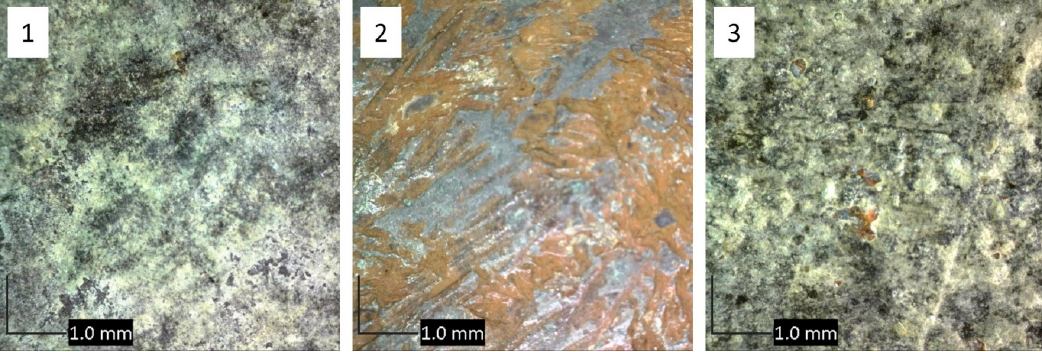
Figure 6. Optical microscopy of studied areas 1–3 on the MC sculpture, as shown in Figure 2. In point 1, EDS revealed two distinctive patina compositions, one mainly containing copper (27 atom %), oxygen (59 atom %), sulfur (3 atom %), and carbon (10 atom %) with some remaining Al and Si. The second kind of patina composition observed had low oxygen content but high Sn content and some sulfur. In Raman spectrum shown in Figure 7a, bands at 191 cm − 1 ; 246 cm − 1 triplet band at 386, 479, and 610 cm − 1 ; strong band at 974 cm − 1 ; and broad band at 1102 cm − 1 , accompanied by characteristic bands at 3402 and 3586 cm − 1 , point to the presence of posnjakite or langite (Table 4). FTIR spectrum (Figure 8) also exhibited absorption maxima typical of copper sulphates